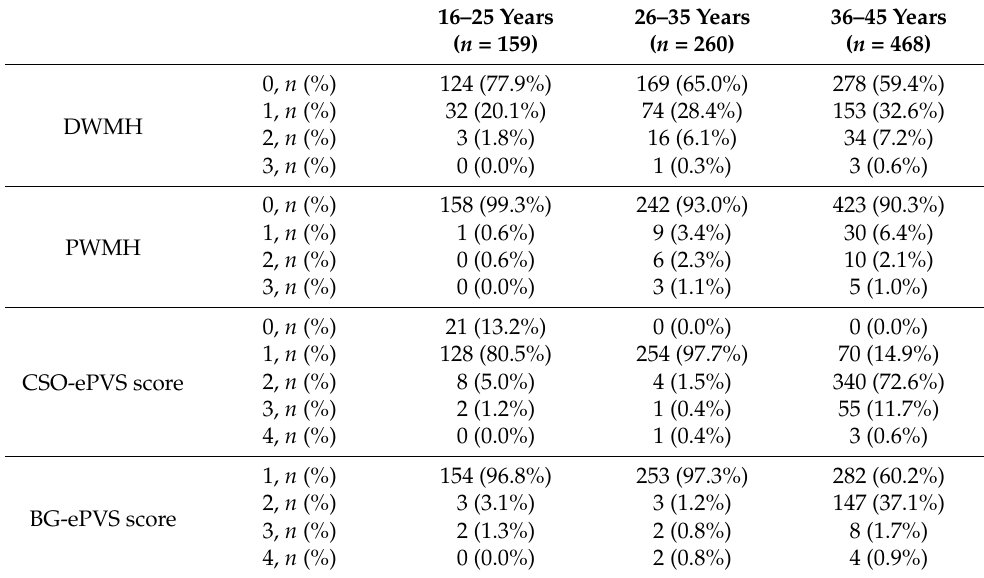
Table 2. Imaging manifestations in subjects grouped by age.